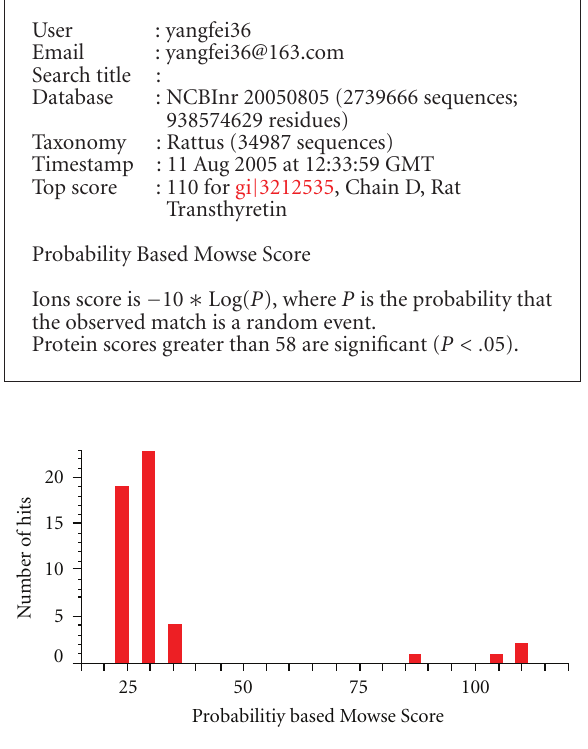
Figure 9: Mascot search results of protein spot 11 are Transthyretin (TTR). Mowse Score is 110 ( > 58, P < . 05).